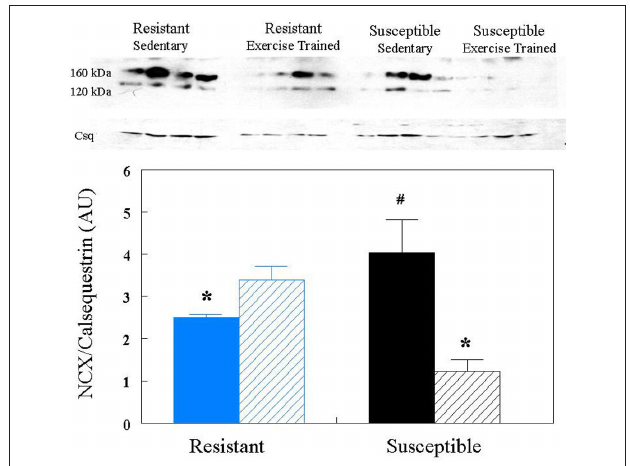
Figure 2 | effect of endurance exercise training on sodium/calcium exchanger (NCX) protein content. NCX levels were determined by Western blot analysis. Protein content was corrected by calsequestrin (Csq) levels. The bar graph represents the average values for all the Western blot gels (i.e., as indicated in the Materials and Methods, the Western blot was performed by two different individuals) AU = arbitrary units; Blue = resistant; black = susceptible; solid bars = sedentary; bars with diagonal lines = exercise trained. * P < 0.05 from susceptible sedentary group, # P < 0.05 from resistant sedentary group.